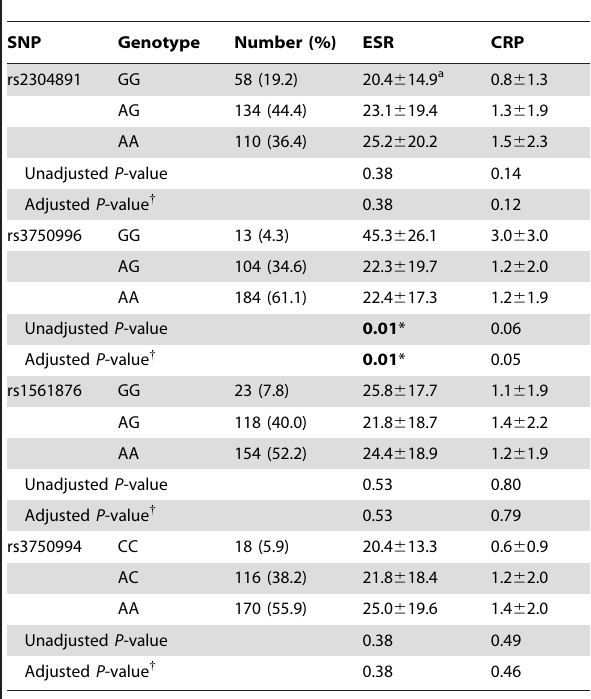
Table 3. Difference in the value of ESR and CRP among HLA- B27 positive AS patients stratified by different STIM1 genotype.